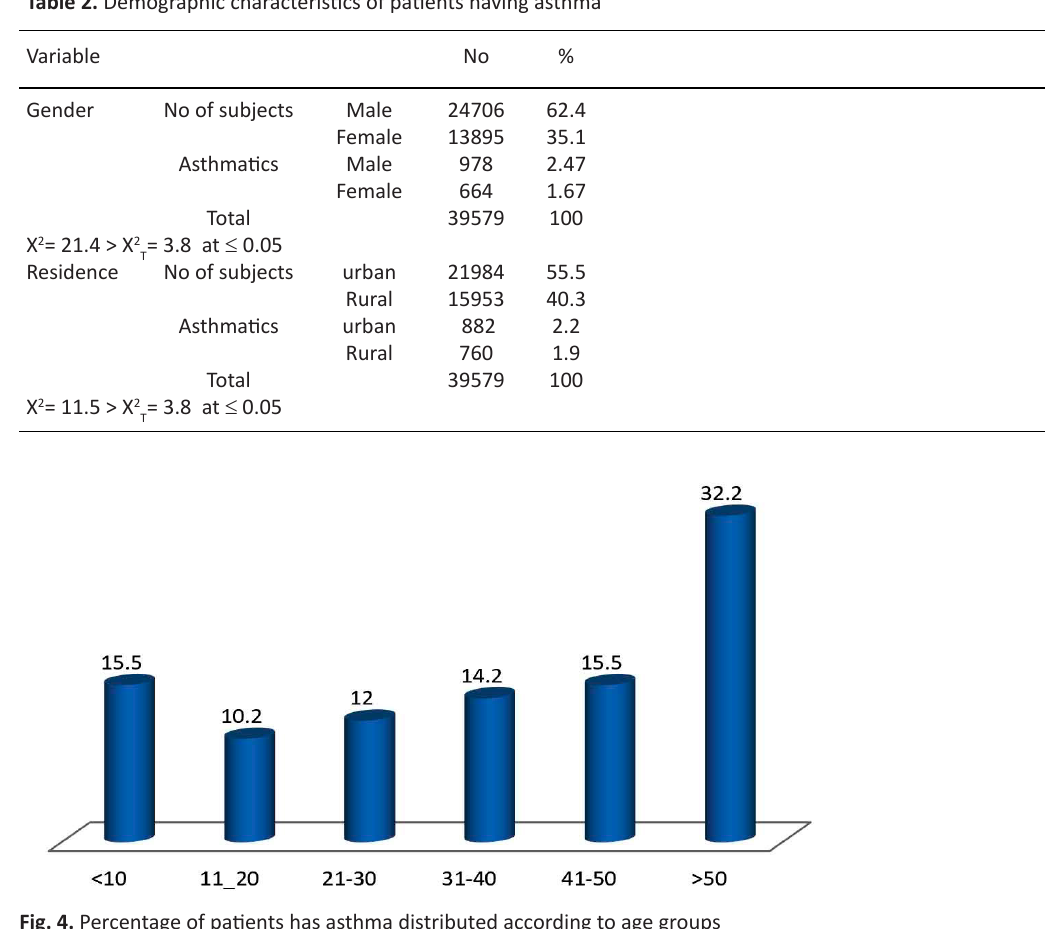
Fig. 4. Percentage of patients has asthma distributed according to age groups